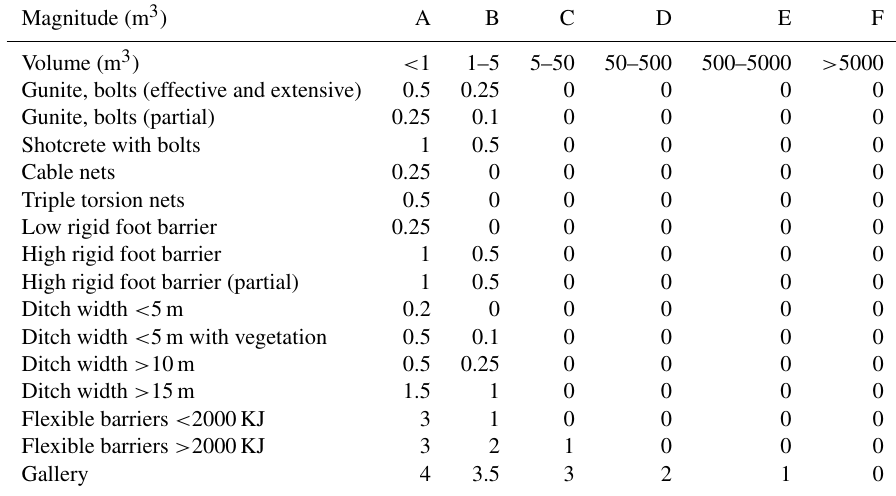
Table 5. Correction factor for different protection measures, to be applied to the annual frequency according to Eq. (3), for each magnitude. Magnitude (m 3 ) A Gunite, bolts (effective and extensive)